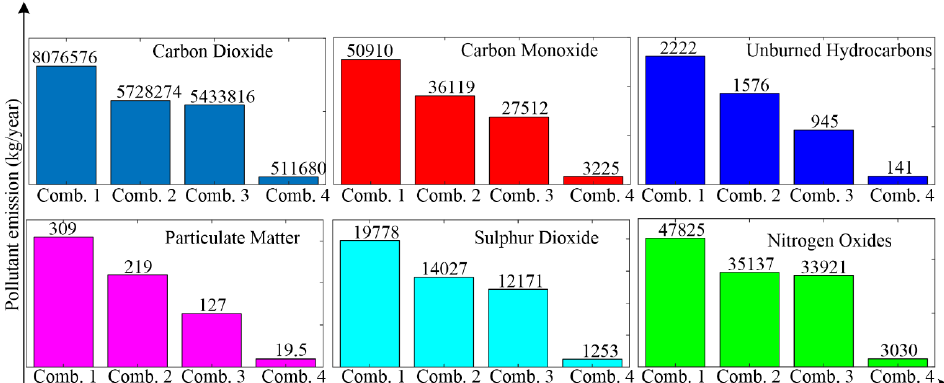
Figure 8. Comparison of pollutants emission: combination 1, 2, 3 &